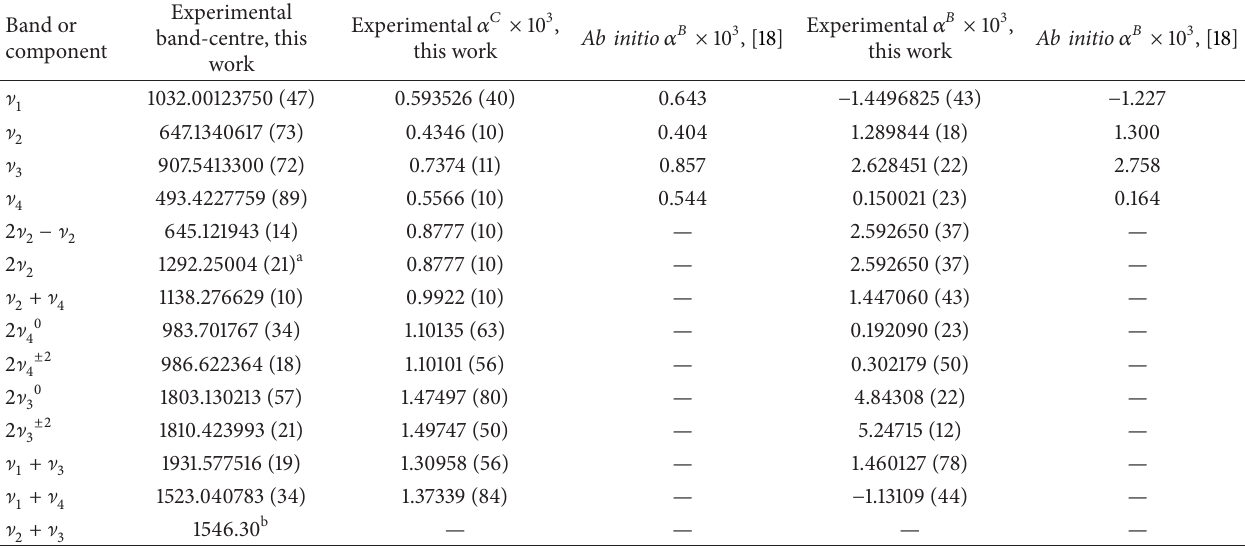
molecule (in cm − 1 ). 3